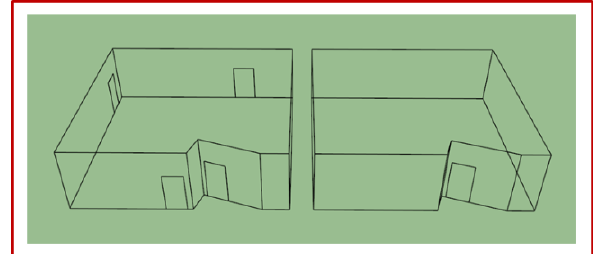
Figure 11. Building indoor model before (left) and after door- candidate pruning